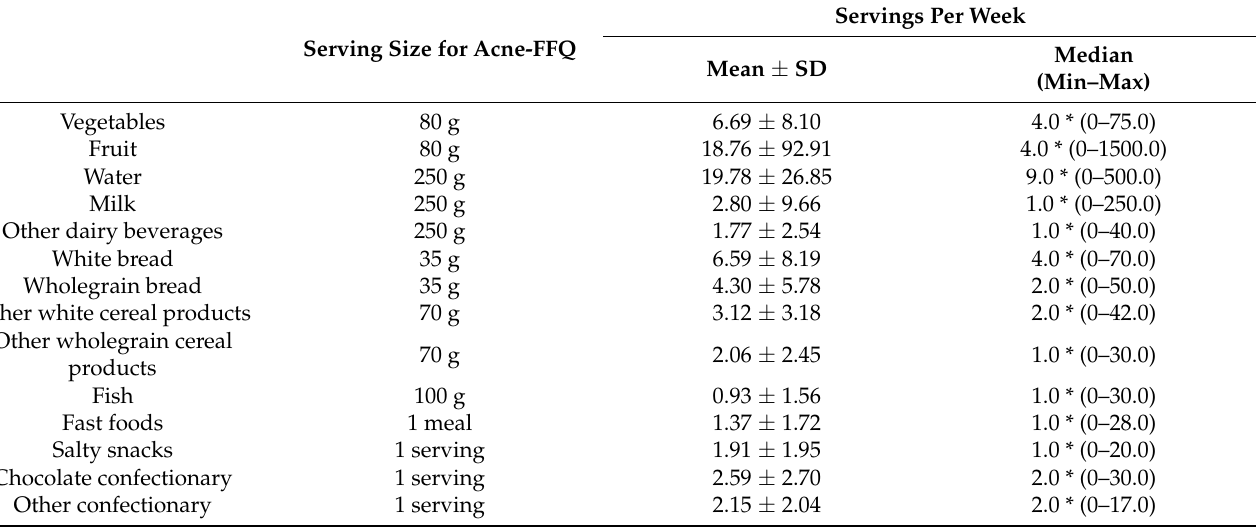
Table 4. The Acne-specific Food Frequency Questionnaire (Acne-FFQ) detailed results in the group of Polish female adolescents participating in the study.